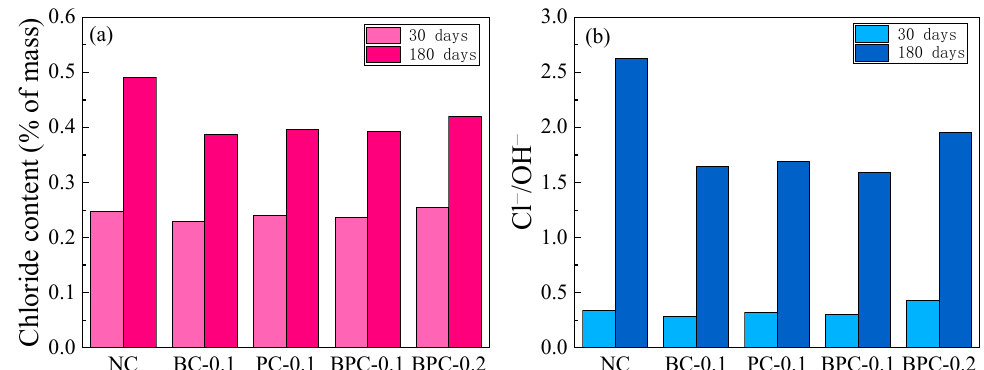
Figure 8. The chloride content and Cl − /OH − ratio of the HBPRC after 30 days and 180 days drying–wetting cycles: ( a ) chloride content; ( b ) Cl − /OH − ratio.